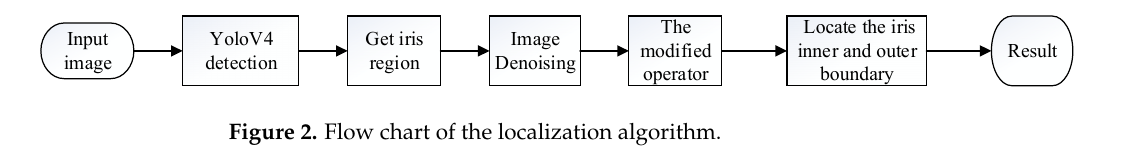
Figure 4. The overall network structure of modified YOLO v4 [44]. 3.2.1. The Backbone MobileNet was proposed by Google in 2017. MobileNetV2 further improves net- work performance by using a reverse residual structure [43]. Because MobileNetV2 con- tains seven bottleneck modules, we used seven blocks in the backbone shown in Figure 4. The backbone outputs the feature maps which are fused at the next part, namely the neck. 3.2.2. The Neck The head and the backbone are joined by the neck. A spatial pyramid pool (SPP) module and a path aggregation network (PAN) make up the neck. The head receives